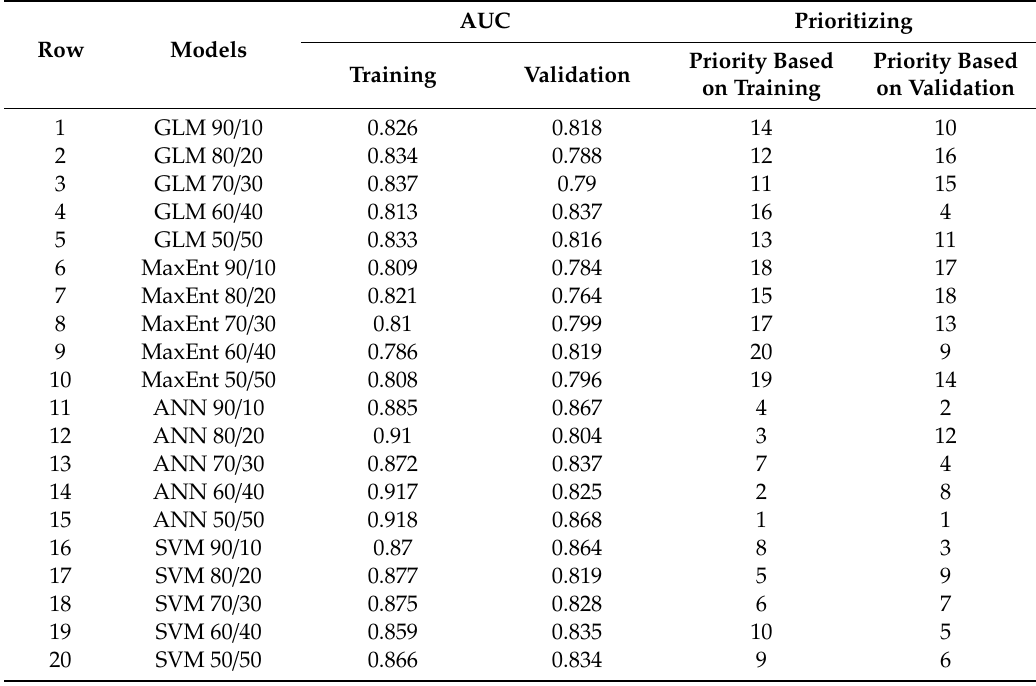
Table 5. Area under the curve values of training and validation data in di ff erent